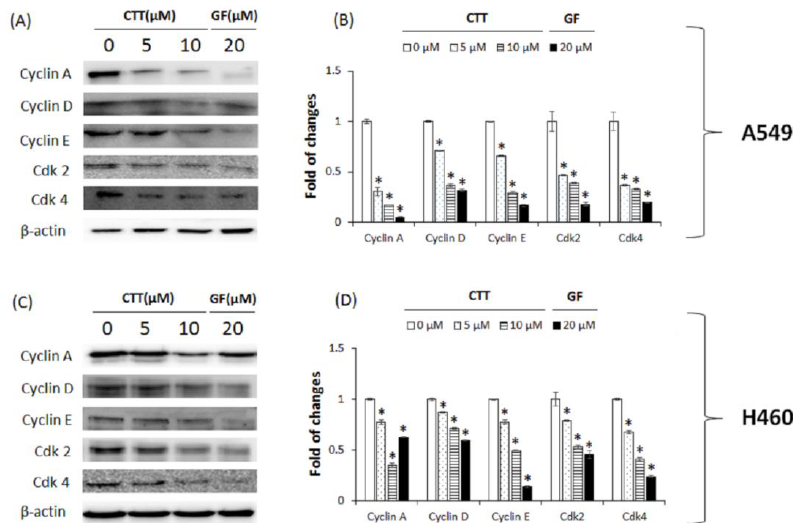
Figure 5. Effects of CTT treatment on the expression of G1 and S cell cycle checkpoint proteins in A549 and H460 cells. ( A , C ) After treatment with 0, 5, or 10 μM of CTT or 20 μM GF (clinical anticancer drug) for 20 h, the protein levels of cyclin A, D, and E and Cdk 2 and 4 were determined through Western blotting. ( B , D ) The calculations of the results were normalized against β-actin. * p < 0.05 compared to the 0 μM of CTT group. The data and images represent each of the three independent experiments. Significant differences for the treated groups were determined by Duncan’s test for multiple comparisons. Values are represented as the mean ± SD from each experiment.